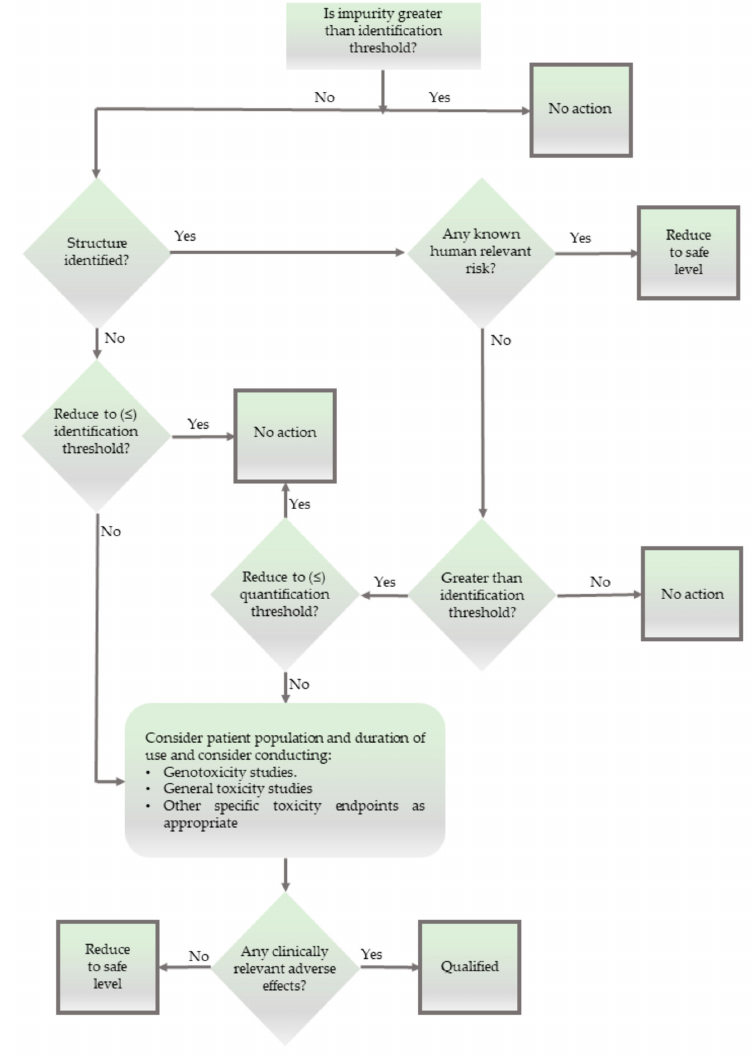
Figure 3. Flowchart of the ICH to identify and deal with impurities in medicines, adequately entitled “The Decision Tree for Identification and Qualification”. Please note that this flowchart explicitly provides scope for impurities which have no identified structure (i.e., impurities which are outside chemical analysis and